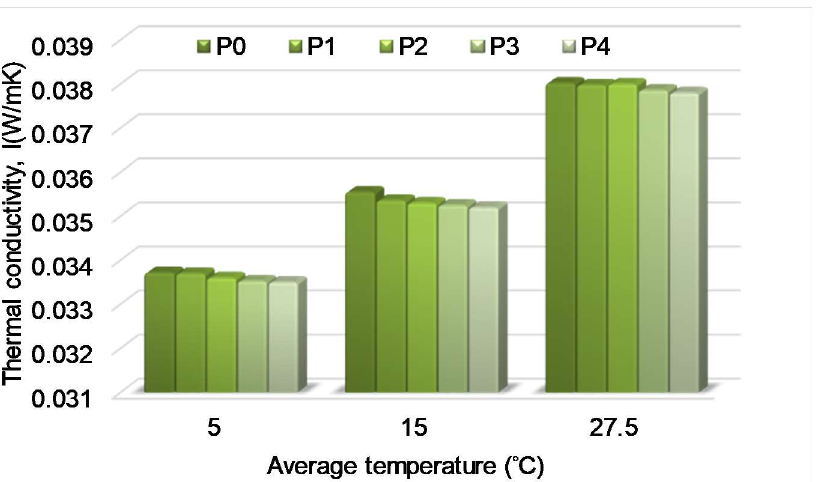
Figure 10. Variation of thermal conductivity of panels obtained for different types of panels in experimental conditions if neglecting the radiation heat transfer. Legend: P0—XPS control panel; P1— panel with perforated horizontal channels; P2—panel with partly perforated symmetric channels; P3—panel with partly perforated alternative channels; P4—panel with perforated inclined channels with an angle α = 45°.